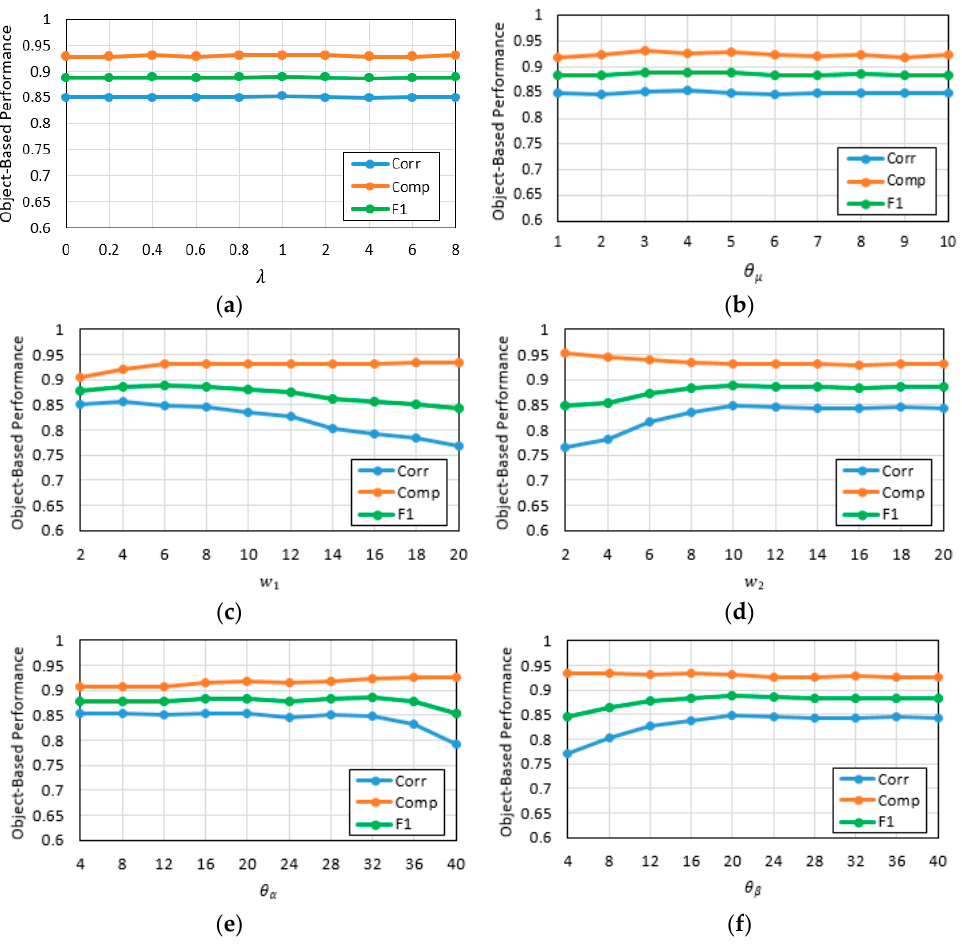
Figure 20. Object-based statistics of building change detection with different parameters. ( a ) Object-based statistics of building change detection with (𝑤 (cid:2869) ,𝑤 (cid:2870) ,𝜃 (cid:3080) ,𝜃 (cid:3081) ,𝜃 (cid:3091) ) = (6.0,10.0,32.0,20.0,3.0) and 𝜆 ranging from 0 to 8; ( b ) object-based statistics of building change detection with (𝜆,𝑤 (cid:2869) ,𝑤 (cid:2870) ,𝜃 (cid:3080) ,𝜃 (cid:3081) ) = (1.0,6.0,10.0,32.0,20.0) and 𝜃 (cid:3091) ranging from 1 to 10; ( c ) object-based statistics of building change detection with (𝜆,𝑤 (cid:2870) ,𝜃 (cid:3080) ,𝜃 (cid:3081) ,𝜃 (cid:3091) ) = (1.0,10.0,32.0,20.0,3.0) and 𝑤 (cid:2869) ranging from 2 to 20; ( d ) object-based statistics of building change detection with (𝜆,𝑤 (cid:2869) ,𝜃 (cid:3080) ,𝜃 (cid:3081) ,𝜃 (cid:3091) ) = (1.0,6.0,32.0,20.0,3.0) and 𝑤 (cid:2870) ranging from 2 to 20; ( e ) object-based statistics of building change detection with (𝜆,𝑤 (cid:2869) ,𝑤 (cid:2870) ,𝜃 (cid:3081) ,𝜃 (cid:3091) ) = (1.0,6.0,10.0,20.0,3.0) and 𝜃 (cid:3080) ranging from 4 to 40; ( f ) object-based statistics of building change detection with (𝜆,𝑤 (cid:2869) ,𝑤 (cid:2870) ,𝜃 (cid:3080) ,𝜃 (cid:3091) ) = (1.0,6.0,10.0,32.0,3.0) and 𝜃 (cid:3081) ranging from 4 to 40.